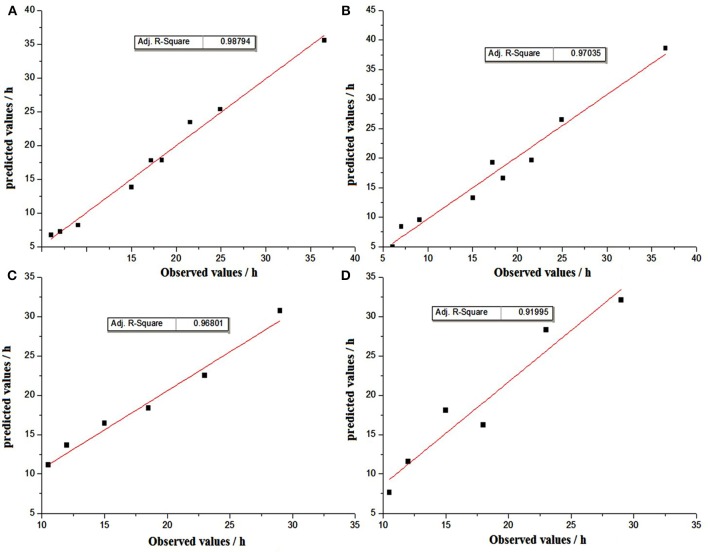
Graphical comparisons beteween observed and predicted TTD values by the method of linear polynomial regression for internal validation (A) and external validation (C); by the method of threshold for internal validation (B) and external validation (D).